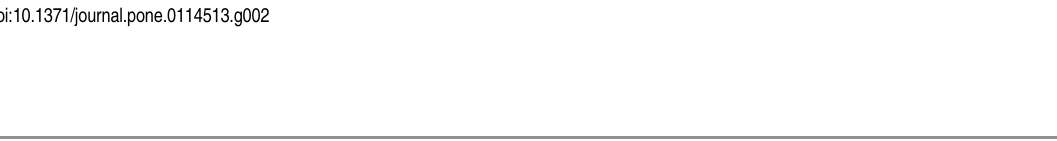
PLOS ONE | DOI:10.1371/journal.pone.0114513 December 9,